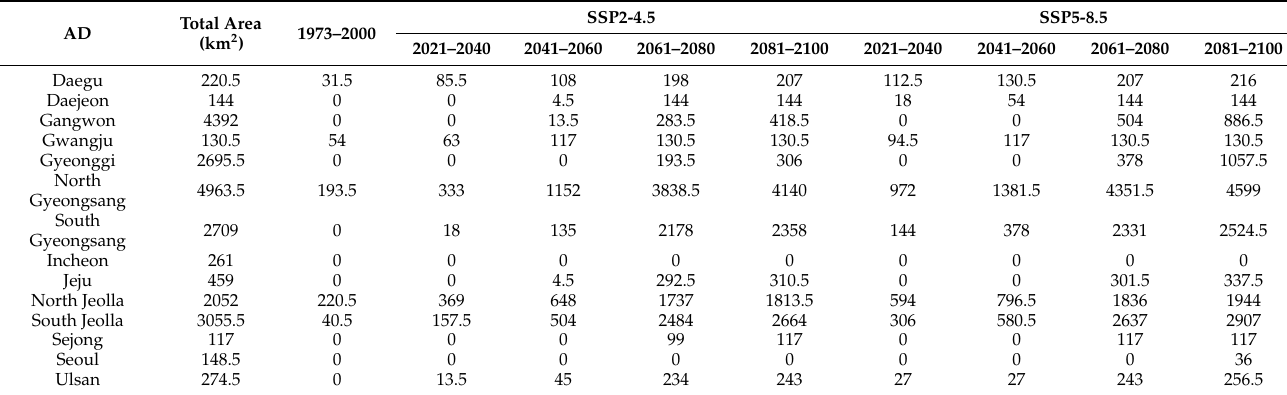
Figure 6. Mean habitat suitability for P. hysterophorus in different ADs of South Korea under the current climate (1973 – 2000) and future climate scenarios (SSP5-8.5; 2021 – 2040, 2041 – 2060, 2061-2080, and 2081 – 2100). Mean habitat suitability was classified into four categories (low, moderate, high, and very high), each of which is indicated with a different color. 4. Discussion The main findings of this study are as follows: First, among the six bioclimatic varia- bles, the annual mean temperature was the most important variable affecting the global